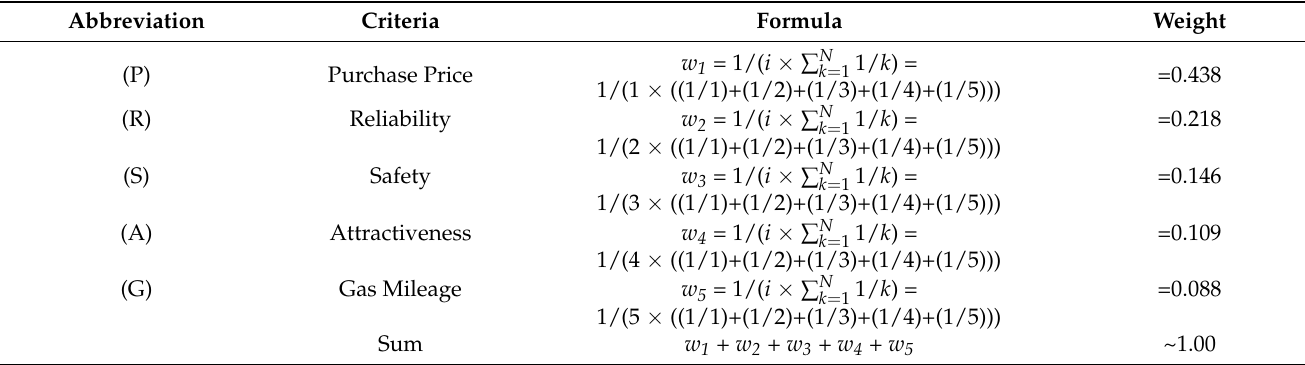
Table 15. Weight using RR